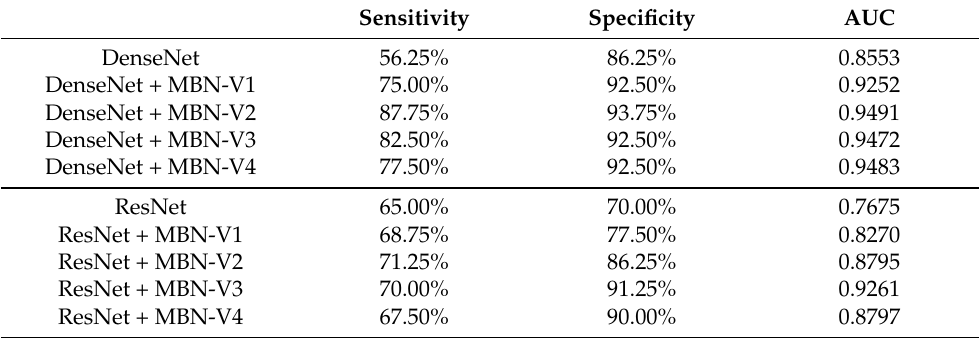
Table 1. Performance comparison with the mask branch network(MBN) on DenseNet-BC and ResNetV2-101 on mass